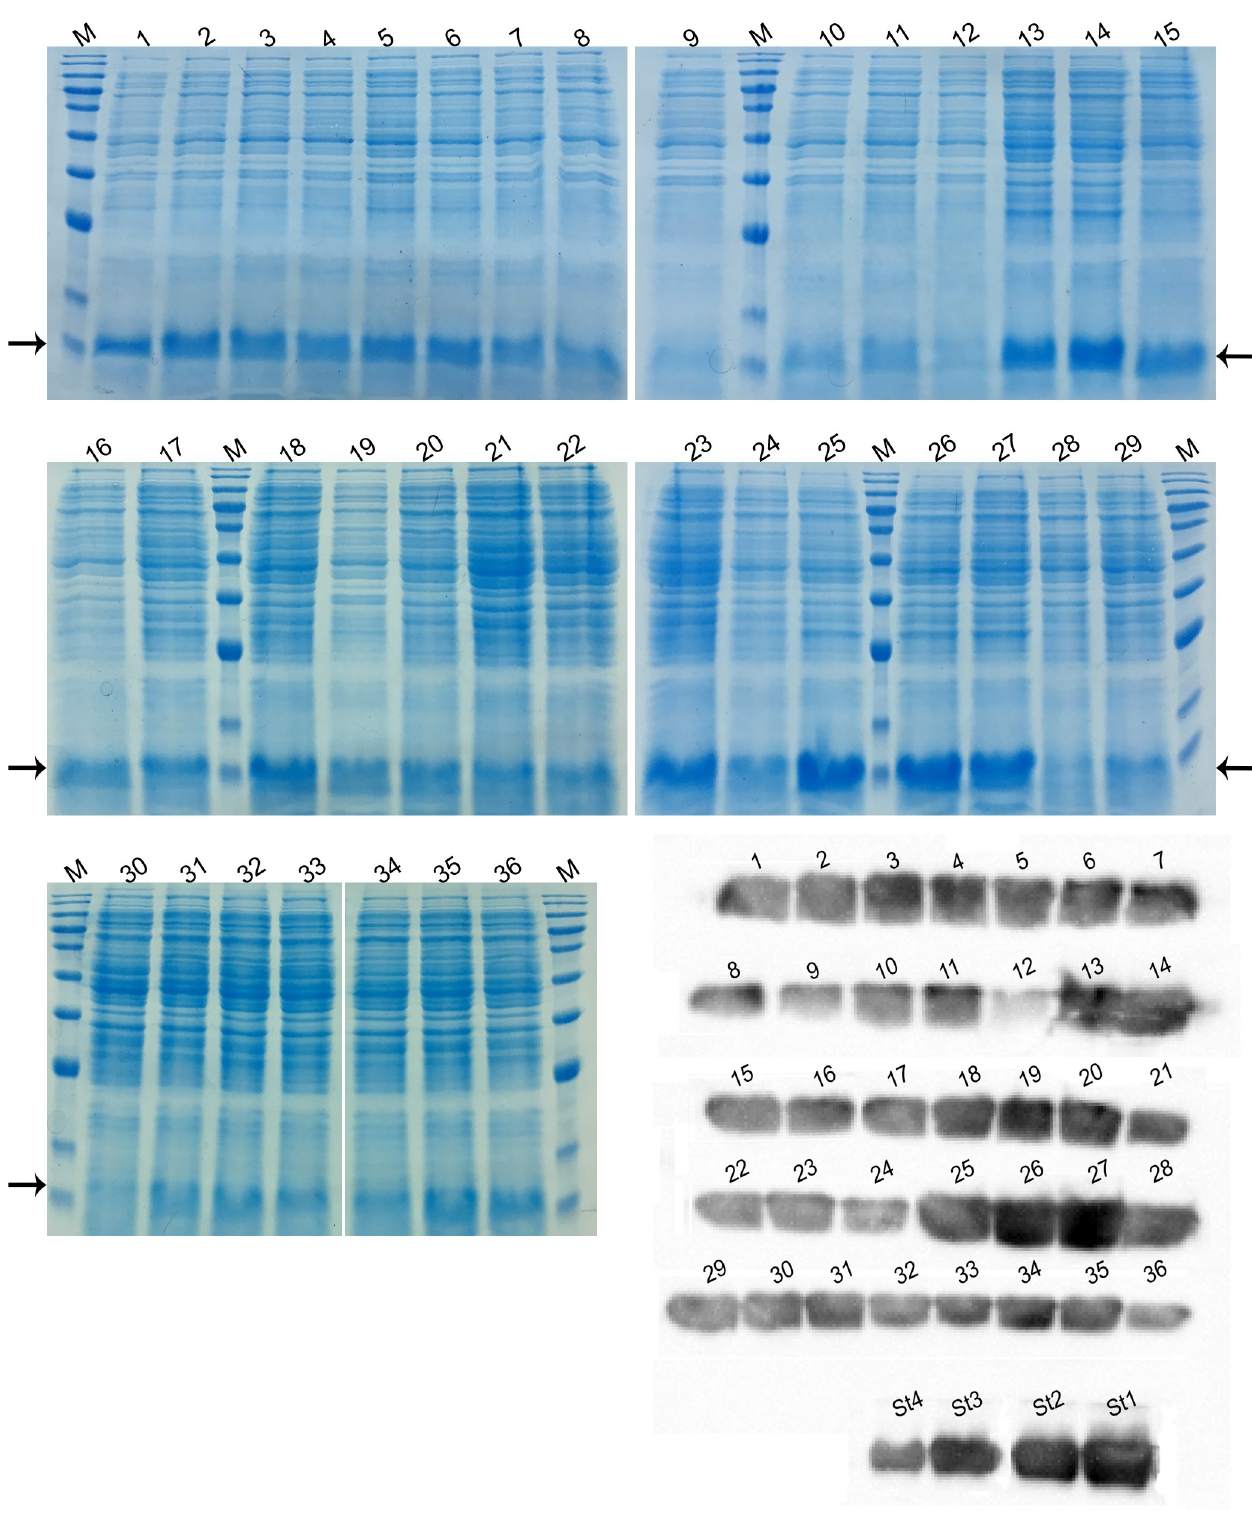
Fig 12. SDS-PAGE and Western blotting analysis of the synergistic effects of glycine, Triton X-100, and IPTG. The various fractions used in the factorial analysis were subjected to SDS-PAGE and Western blotting analysis. The fractions are labeled 1 through 36. A known concentration of the rPF4 was serially diluted and served as standard in order to extrapolate the amount of secretion in each fraction. Serially diluted rPF4 bands are labeled St1 through St4 in order of decreasing concentration. The rPF4 bands are indicated by arrows, M denotes the molecular weight marker. https://doi.org/10.1371/journal.pone.0232661.g012 PLOS ONE | https://doi.org/10.1371/journal.pone.0232661 May 7,